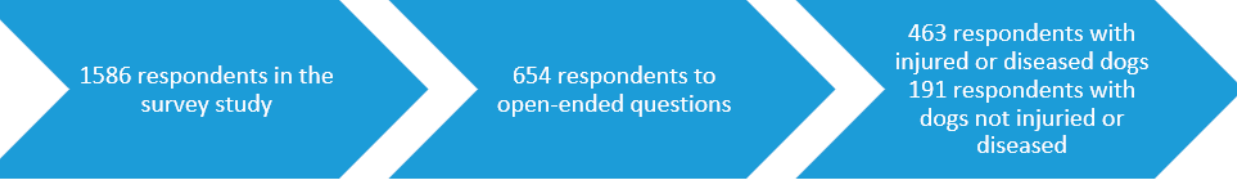
Figure 1. Flow chart illustrating enrolled respondents. Table 1. Overview of categories, subcategories and codes merged from narrative data in the quali- tative content analysis.